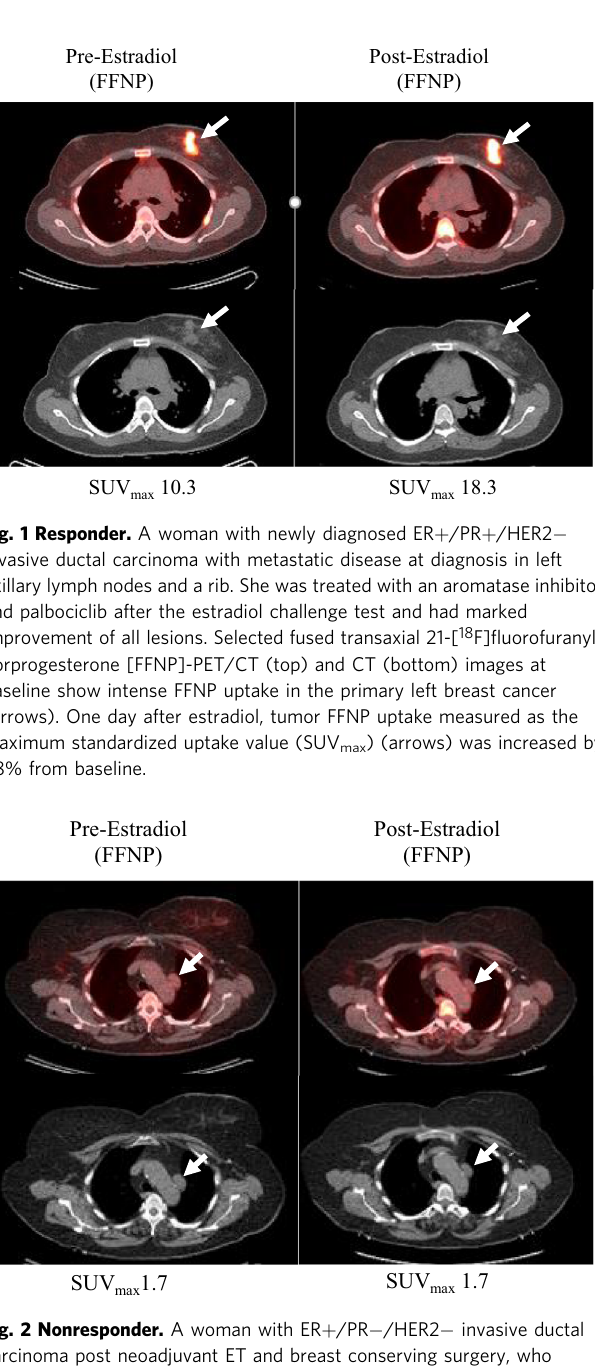
(Q1 – Q3): 3.7 (2.6 – 4.7) versus 2.8 (2.3 – 4.4), p = 0.18) (Table 3). Following estradiol challenge, however, tumor FFNP uptake was